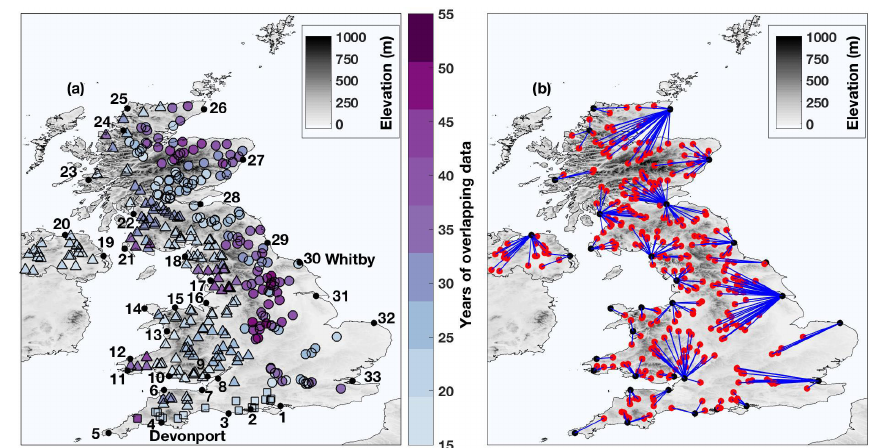
Figure 1. (a) Location and overlapping data length (in years) of the 33 tide gauge sites (black dots) and 326 river discharge stations (triangles, circles, and squares show the river stations that discharge onto the western, eastern, and southern coasts, respectively), and (b) pairing of the tide gauge and river discharge